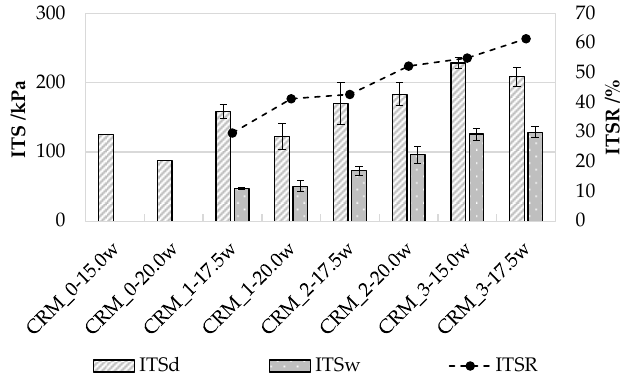
Figure 8. Indirect tensile strength (ITS d in dry conditions, ITS w after soaking) and strength ratio (ITSR) at 20 °C.